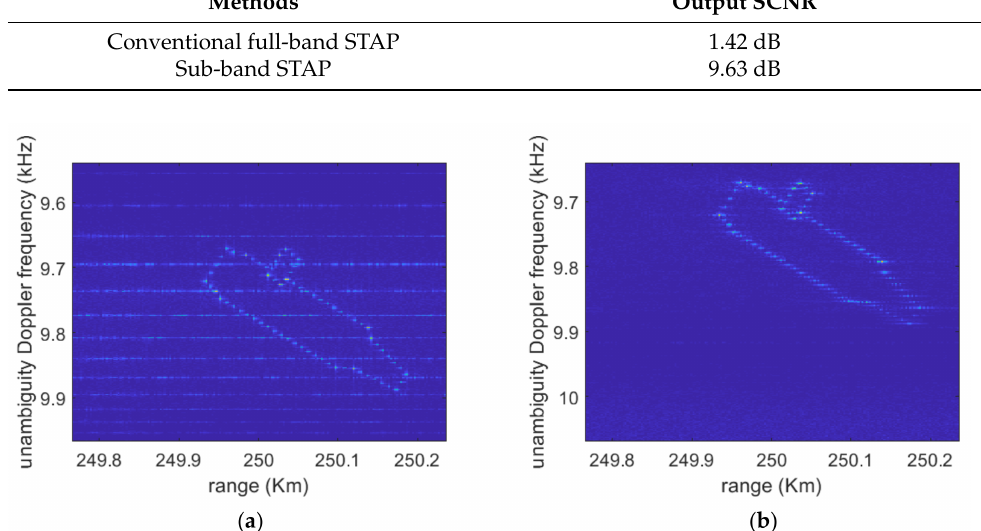
Figure 4. Simulation results of ISAR imaging. ( a ) Sliding window STAP-based ISAR imaging result. ( b ) ISAR imaging result of the proposed